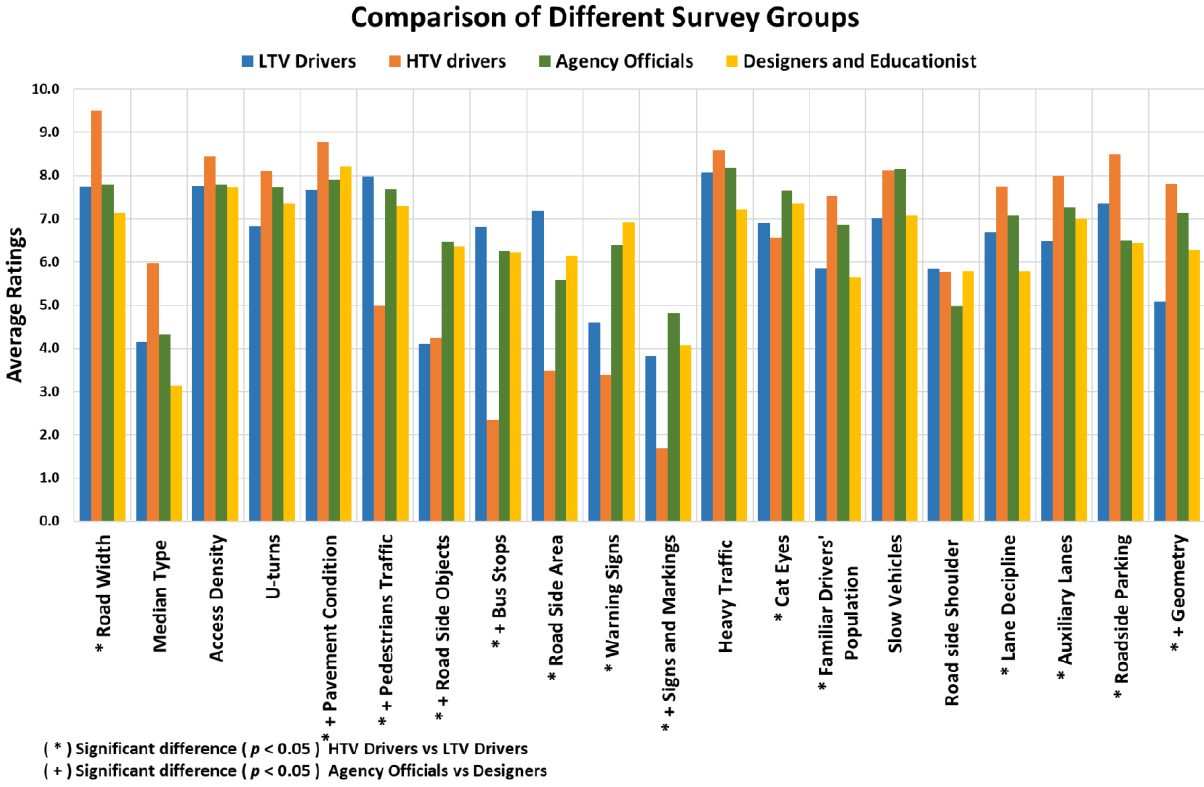
Figure 5. Difference of Opinion Between Survey Groups.